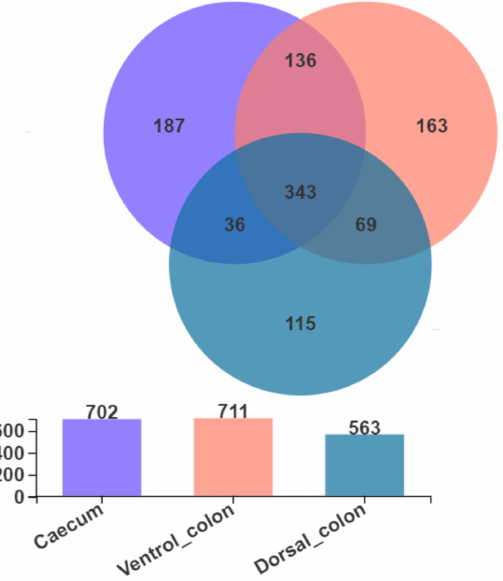
Figure 2. Venn diagram presented the distribution of fungal community OTUs across the caecum, ventral colon, and dorsal colon.